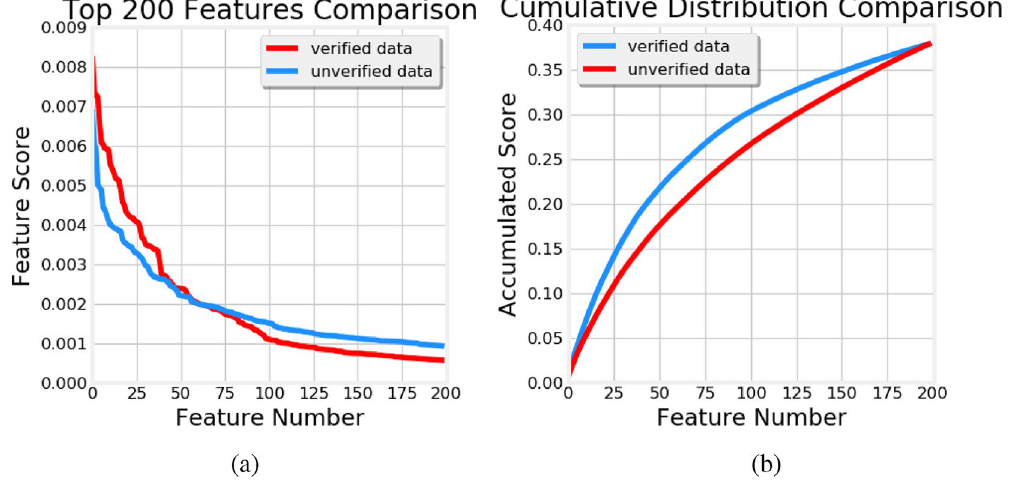
Figure 4. ( a ) Weights and ( b ) cumulative distribution of the weights of top-200 features